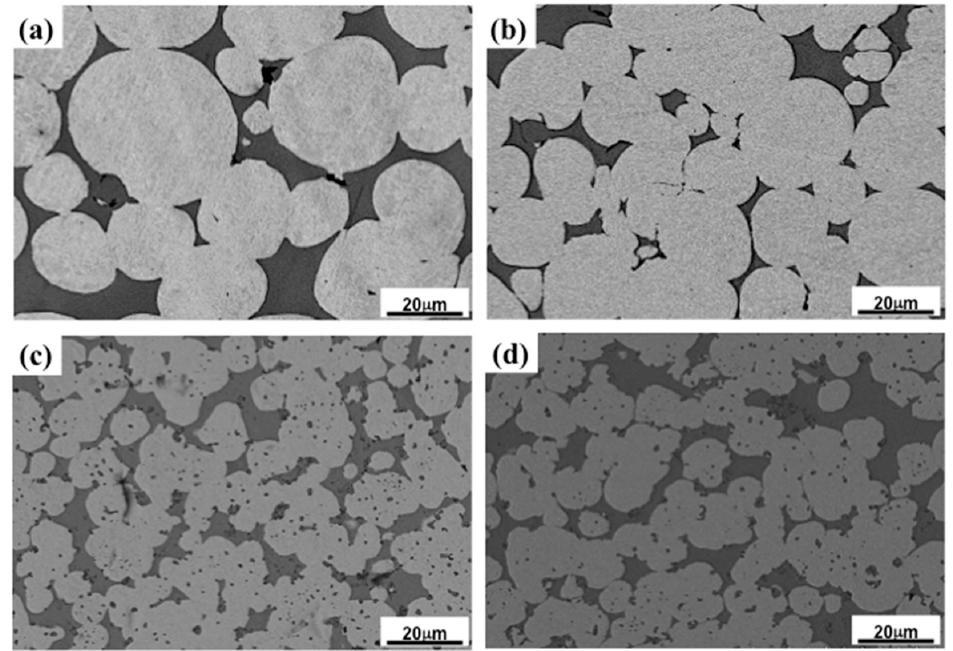
Figure 4. Scanning election microscope (SEM) images of the sintered ( a ) W3Mo, ( b ) W12Mo, ( c ) W3Mo-YO, and ( d ) W12Mo-YO model alloys milled for 24 h.